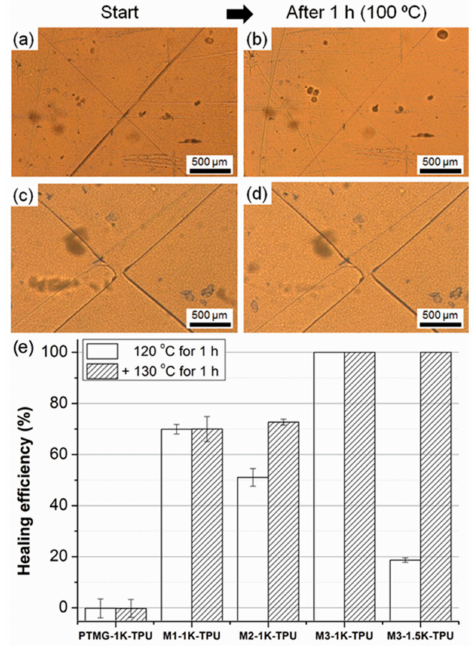
Figure 9. Optical microscopy images of the X-shaped scratch on the TPU films of ( a , b ) M3-1K-TPU and ( c , d ) PTMG-1K-TPU before and after healing for 1 h at 100 ◦ C. ( e ) Healing efficiencies of TPU films after 1 h at 120 ◦ C and +1 h at 130 ◦